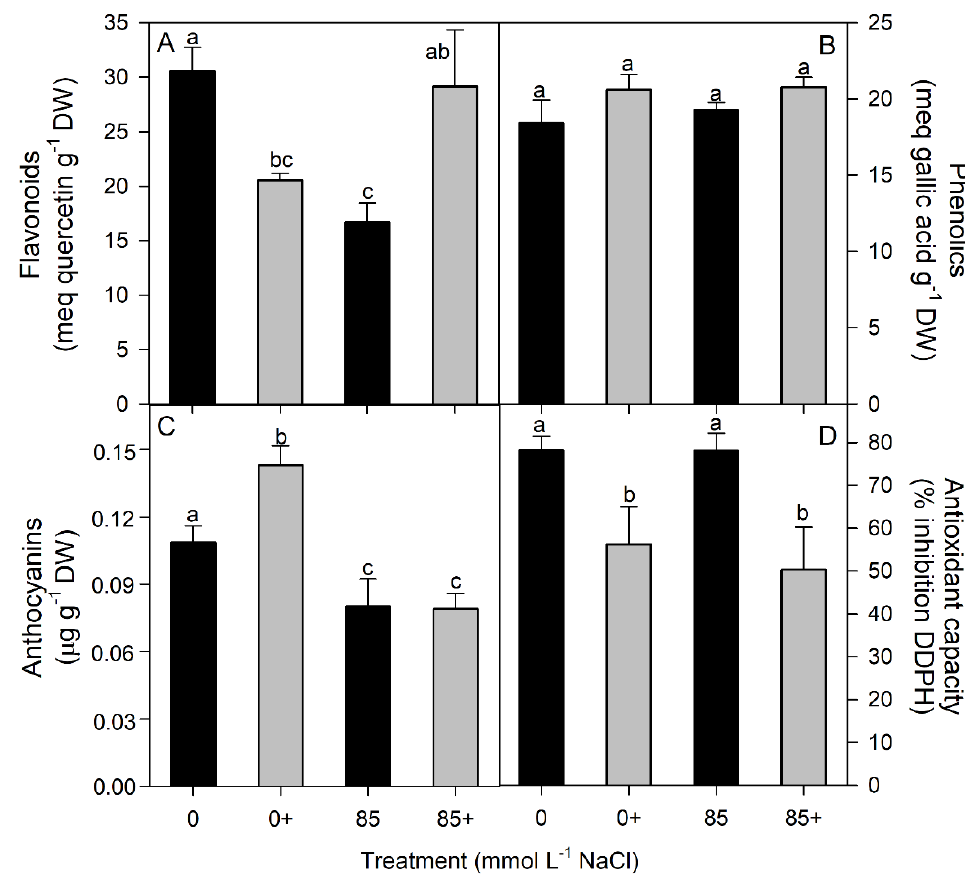
Figure 6. Flavonoids ( A ), phenolics ( B ), anthocyanins ( C ), and antioxidant capacity ( D ) of Swiss chard after 30 d of treatment with 0 and 85 mmol L − 1 NaCl, non-inoculated and inoculated (+). Each value represents the mean of six replicates ± SE (nine replicates for anthocyanins). Different letters indicate means that are significantly different from each other (ANOVA; Duncan test, p <0.05).